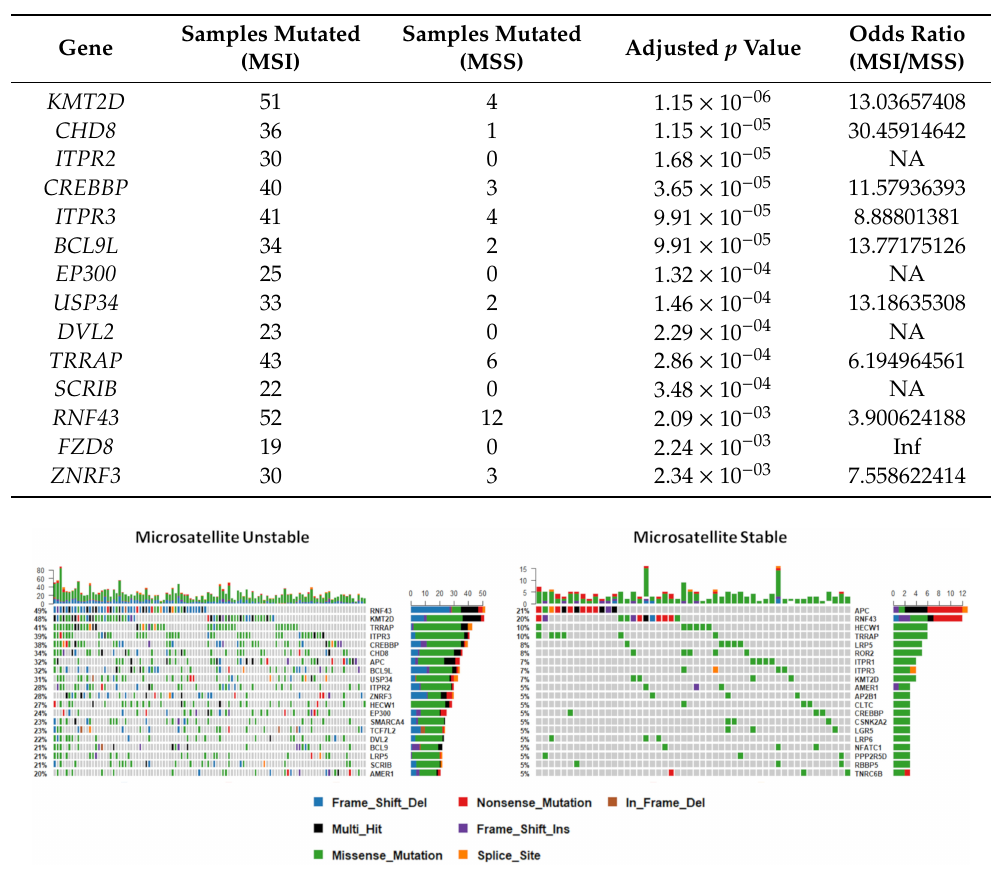
Figure 4. The mutational landscape of WNT signaling regulators by microsatellite instability status. Note that this analysis is limited to cancers with microsatellite instability status available ( n =